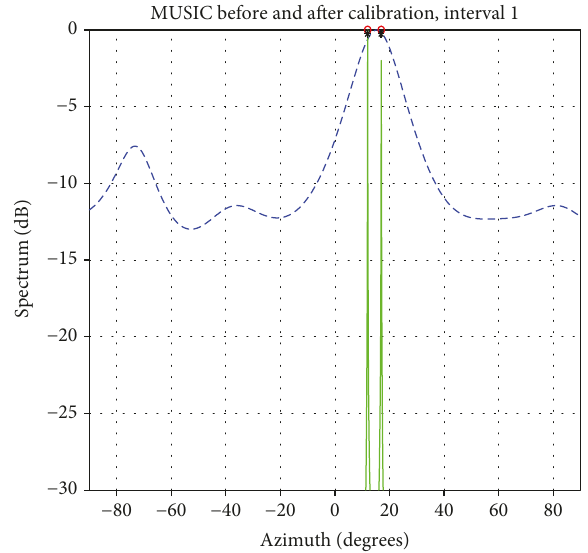
Figure 9: The MUSIC spectrum for two closely spaced signals using the initial (dashed line) and final (solid line) values of ̂ D. The true and estimated DOAs are indicated by red “o” and black